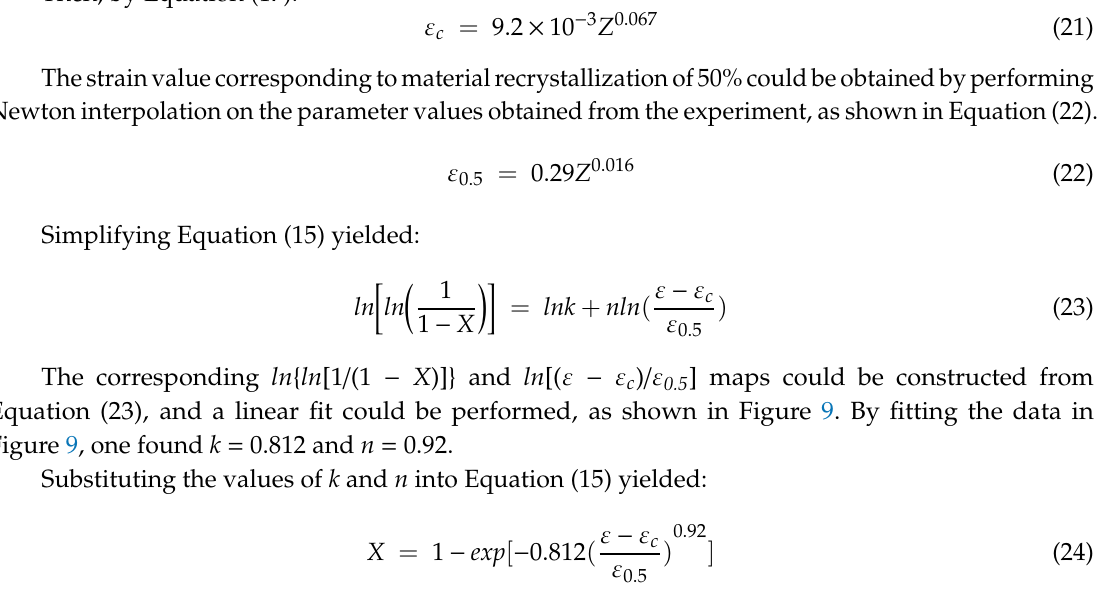
. ε Table 3. Strain rate , peak strain ε p , dynamic recrystallization volume fraction X , and lnZ at di ff erent